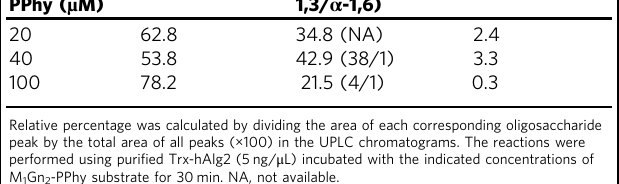
Relative percentage was calculated by dividing the area of each corresponding oligosaccharide peak by the total area of all peaks (×100) in the UPLC chromatograms. The reactions were performed using puri fi ed Trx-hAlg2 (5ng/ μ L) incubated with the indicated concentrations of GDP-Man for 30min. NA, not available.